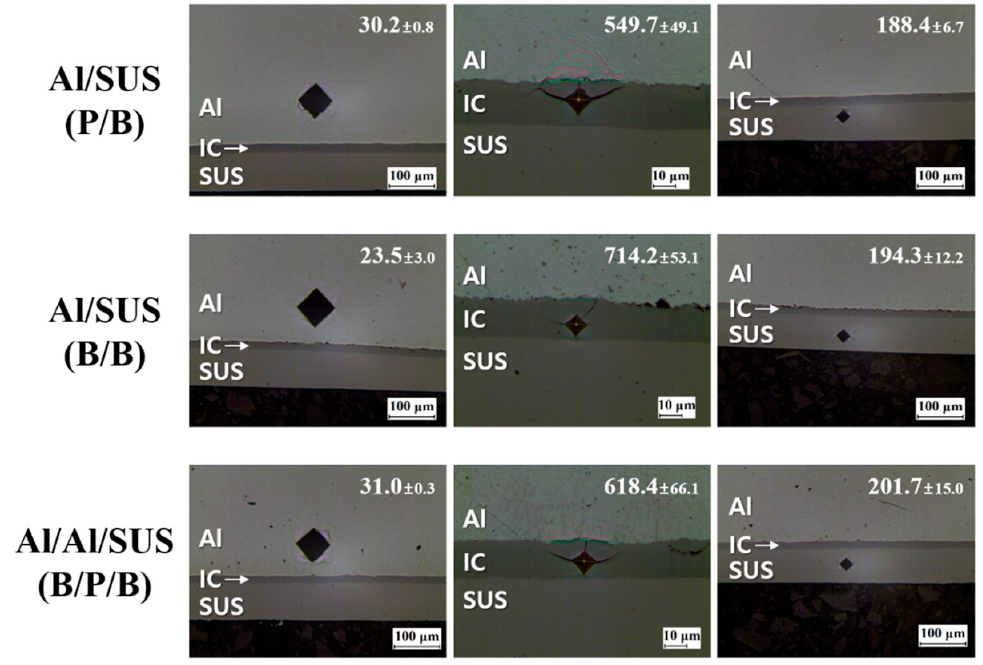
Figure 4. Thermal conductivities and coefficients of thermal expansion of Al/SUS clads.